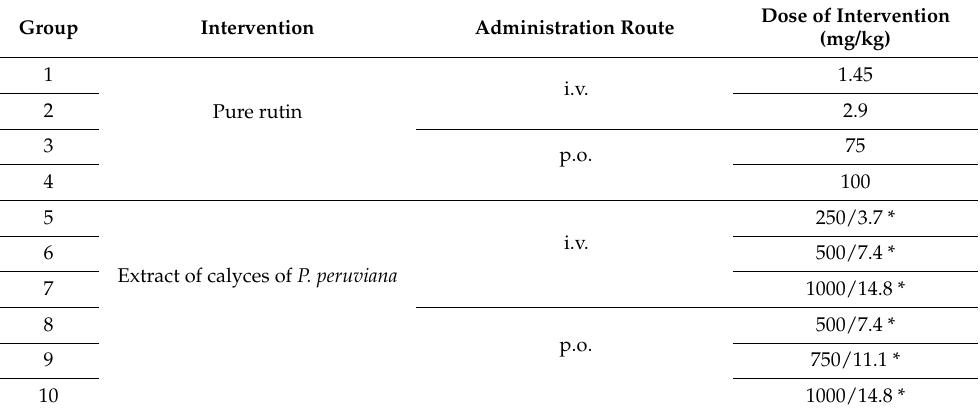
Table 1. Groups for pharmacokinetic (PK)